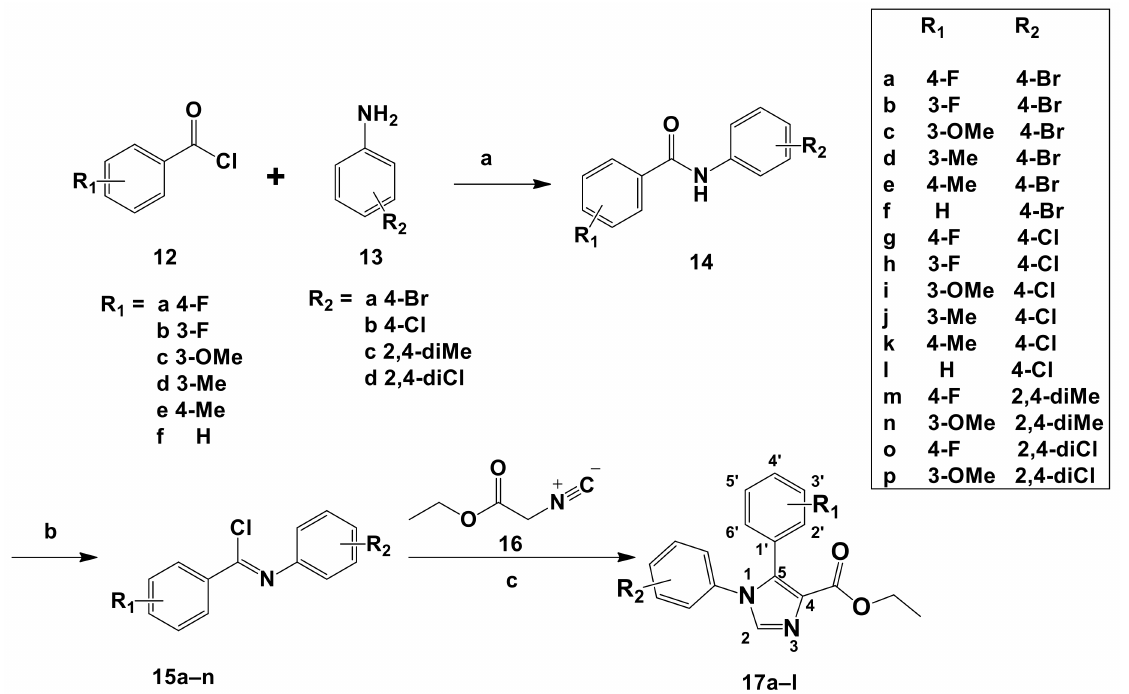
Scheme 2. Synthesis of compounds 14 – 17 . Reaction conditions: (a) Et 3 N , AcOEt, RT, 24 h; (b) SOCl 2 , reflux, 16 h; (c) ethyl isocyanoacetate, DBU, anhydrous THF, − 78 ◦ C–RT, 48